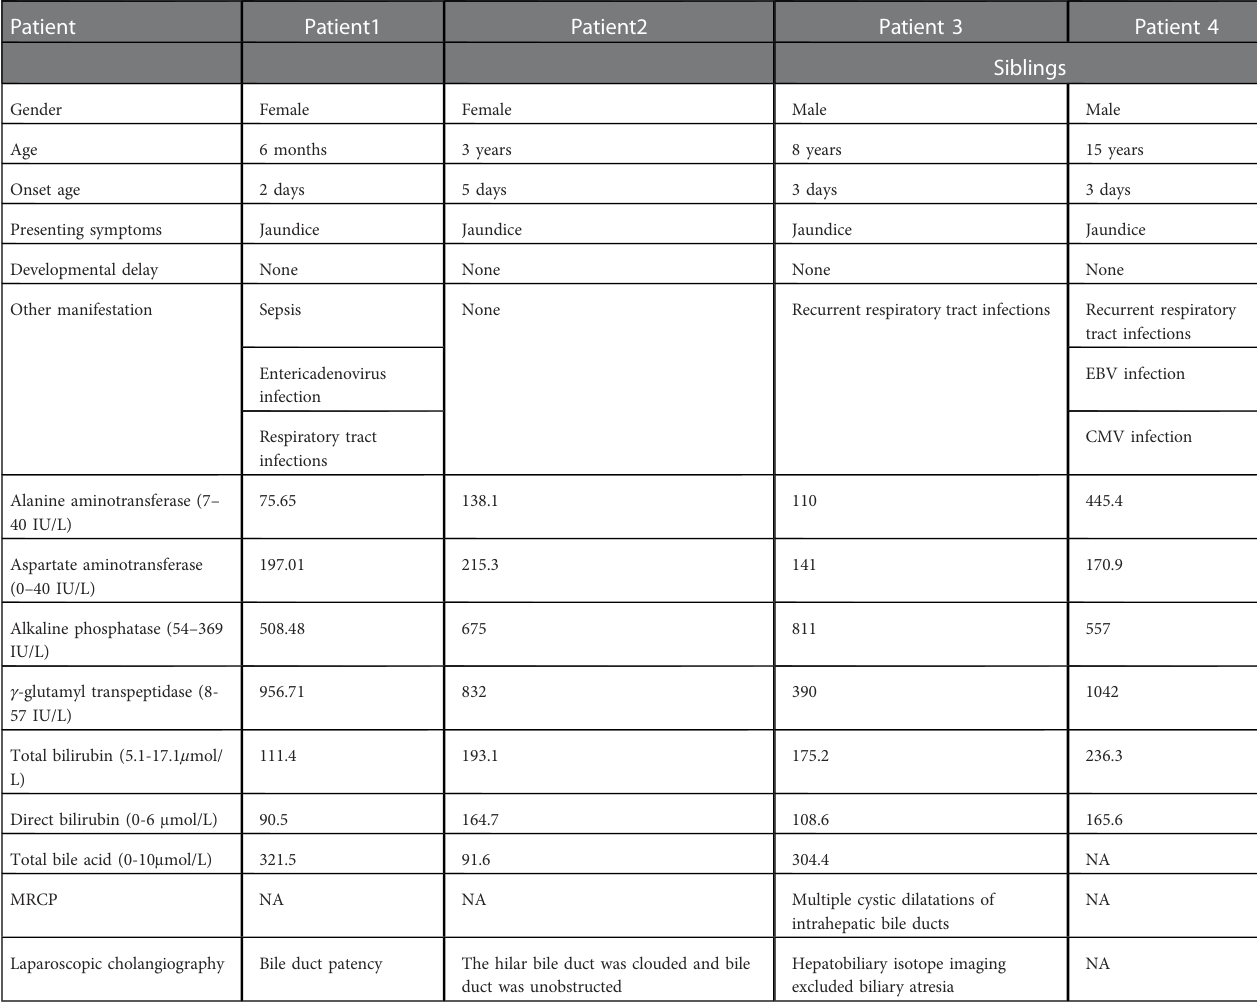
TABLE 1 The clinical data and predominant laboratory investigations of four Chinese